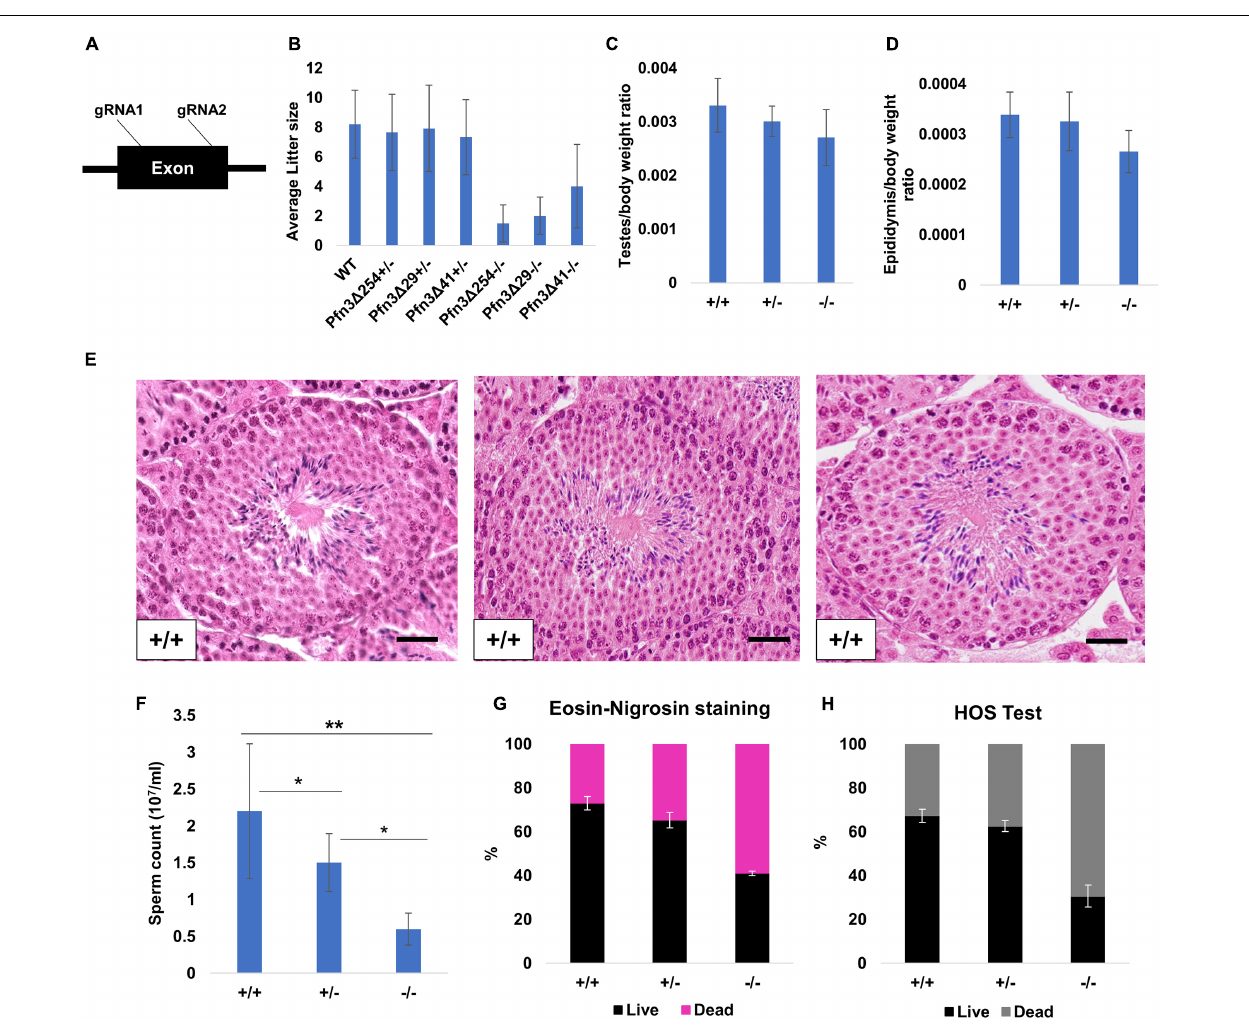
FIGURE 2 | Generation and characterization of Pfn3 -deficient mice. (A) Schematic representation of Pfn3 genomic locus with targeting sites of designed gRNAs. (B) Mating statistics of wild-type, Pfn3 (cid:49) 254, Pfn3 (cid:49) 41, and Pfn3 (cid:49) 29 heterozygous and homozygous ( n = 5/ Pfn3 -deficient mouse model) males. Successful mating of heterozygous and homozygous males with wild-type females was indicated by the presence of a vaginal plug at 0.5 dpc. (C,D) Relative weights of testes and cauda epididymis are comparable between all three genotypes of Pfn3 (cid:49) 254 ( n = 13). (E) H & E staining on Pfn3 + / + , Pfn3 + / − , and Pfn3 − / − testes section. (F) Sperm count comparison in Pfn3 + / + , Pfn3 + / − , and Pfn3 − / − littermates ( n = 13). (G) Eosin and nigrosine staining on biological replicates ( n = 3) of Pfn3 + / + , Pfn3 + / − , and Pfn3 − / − sperm. (H) Hypo-osmotic swelling test on biological replicates ( n = 3) of Pfn3 + / + , Pfn3 + / − , and Pfn3 − / − sperm. At least 200 spermatozoa were evaluated per